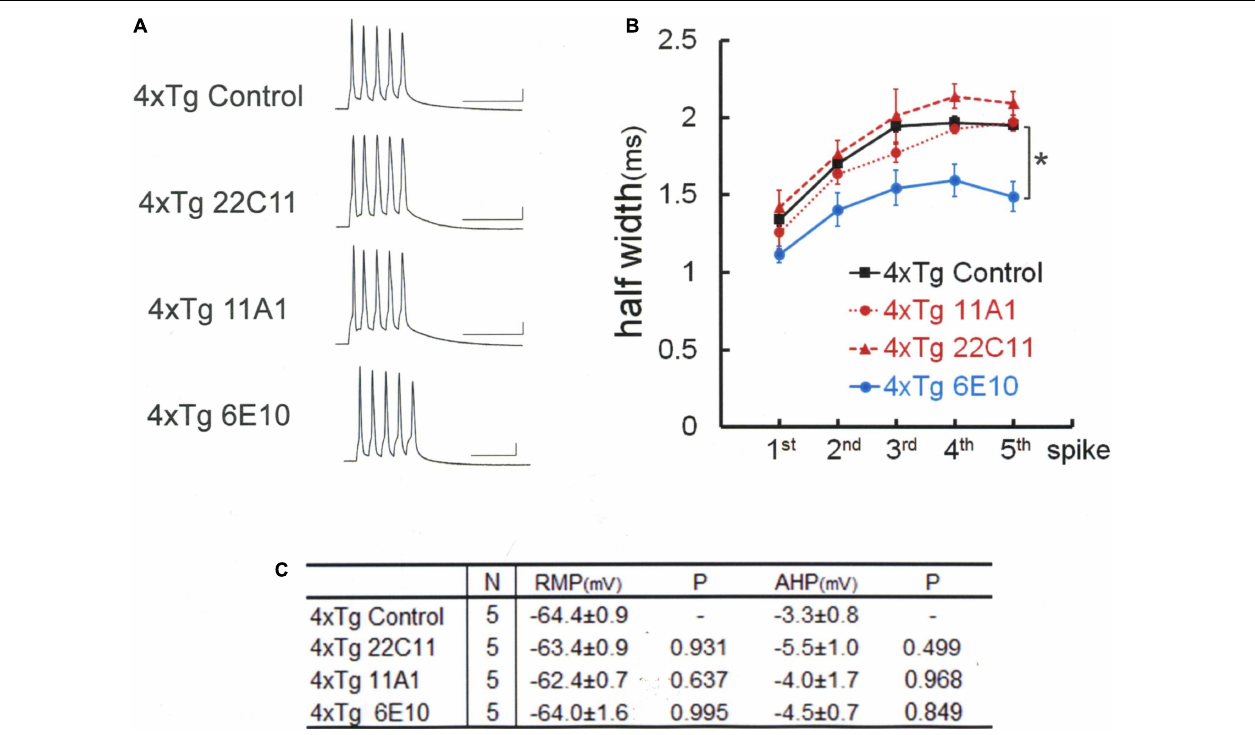
FIGURE 5 | Spike broadening is blocked by 6E10, but not by anti-APP (22C11) or anti-A β oligomer (11A1) antibodies in 4xTg mouse neurons. (A) Specimen recordings of spike trains under the injection of anti-A β oligomer (11A1) or anti-APP (22C11) antibodies. Scale bars, 50 ms and 20 mV. (B) Averaged spike half-width during the five-spike train (black line and square, 4xTg Control; red dashed line and triangle, 4xTg 22C11; red dotted line and circle, 4xTg 11A1; blue line and circle, 4xTg 6E10). With 6E10, spike half-widths in 5th spikes were significantly smaller than in Control (* P = 0.025). With 22C11 or 11A1, there were no significant differences. (C) Basic membrane properties of recorded neurons. Convention is the same as in Figure 1 .